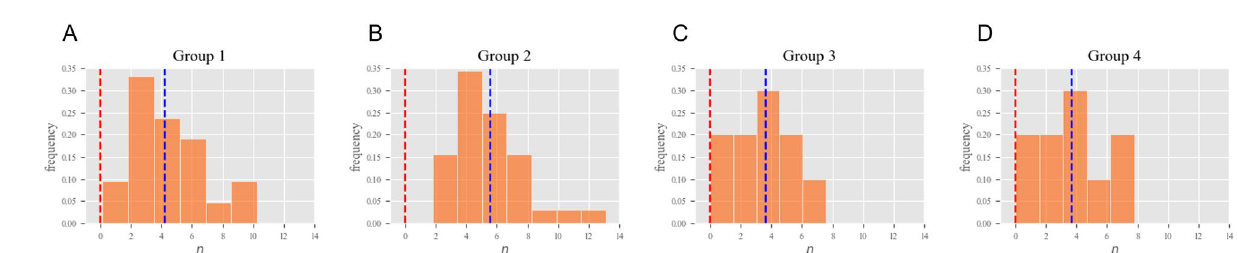
Figure 1. Examples of fittings for an individual of each group. Selected individuals are those for which there were more available data points. From left to right, individuals belong to groups 1, 2, 3, and 4. Shown in each case is χ( t ) , the fraction of links whose “distance” to the individual is not larger than t . Red dots are actual data, representing the number of individuals who receive no more grooming than a fraction t of the maximum. The blue dashed line is the fitted function χ( t ) , and the blue-shadowed region is the interval of confidence.